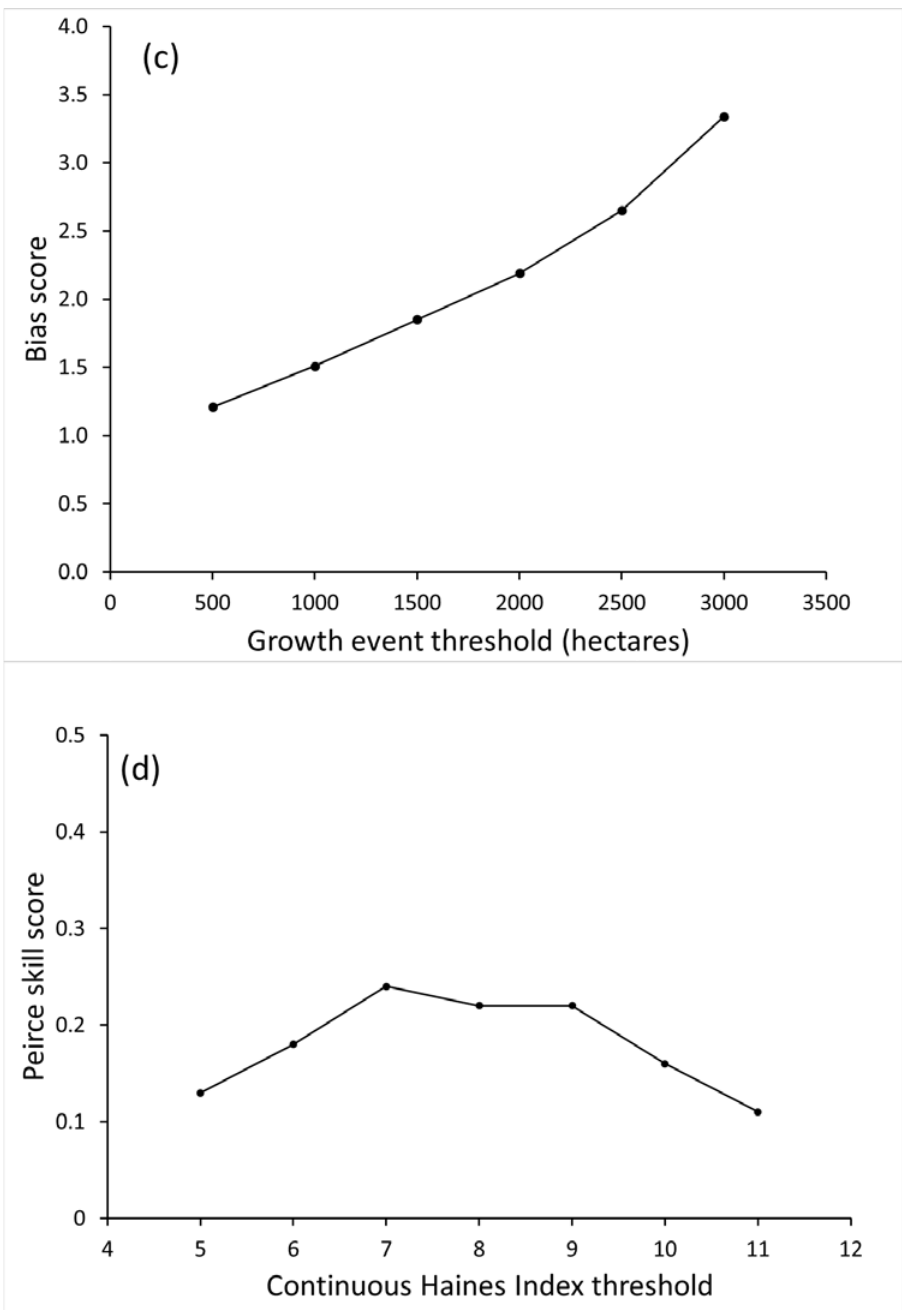
Figure 7. Summary scores for the Continuous Haines Index (C-Haines) with index threshold 6, for event growth thresholds from 500 to 3000 ha: ( a ) TPR and MR; ( b ) Peirce skill scores; ( c ) Bias scores; ( d ) Peirce skill score dependence on threshold chosen for Continuous Haines Index.